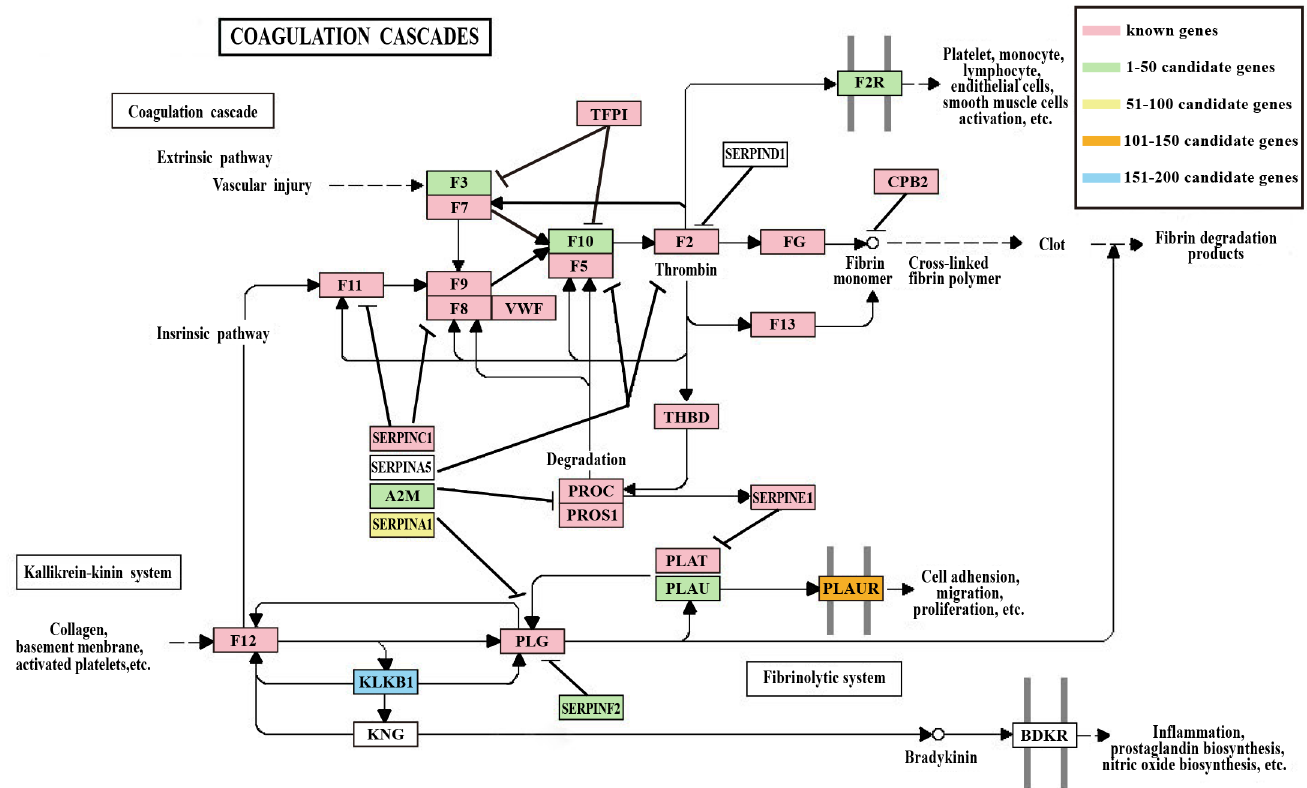
Fig 7. Coagulation cascades pathway. The red, green, pink, orange and blue rectangles present known genes in the top 1 – 50, top 51 – 100, top 101 – 150 and top 151 – 200 candidate